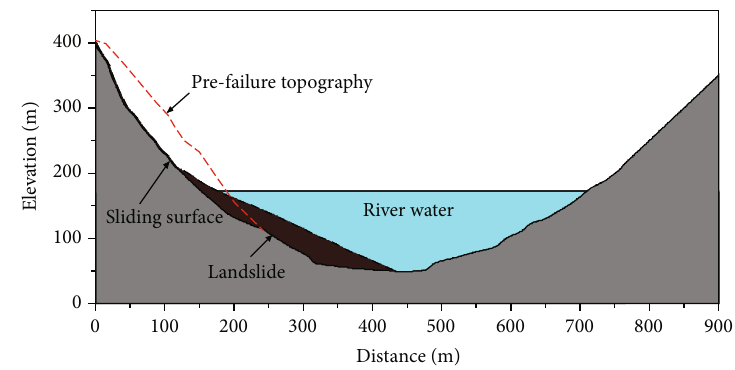
Figure 5: Numerical model of the Gongjiafang landslide.